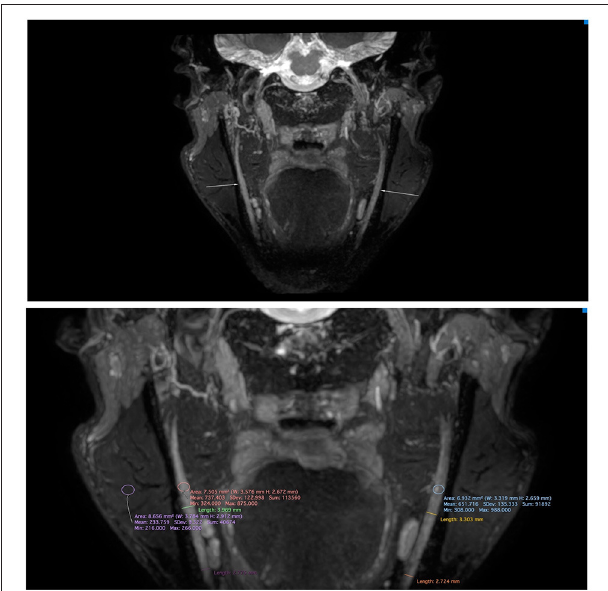
FIGURE 1 | Magnetic resonance neurography of the mandibular nerve on a 3T Philips Ingenia with standard 32 channel head coil (Philips, Best, the Netherlands) applying a 3D CRANI sequence (4). The image was reconstructed using maximum intensity projection and multiplanar reformatting. Note the slightly increased nerve calibers and signal intensities, which are more pronounced on the right inferior alveolar